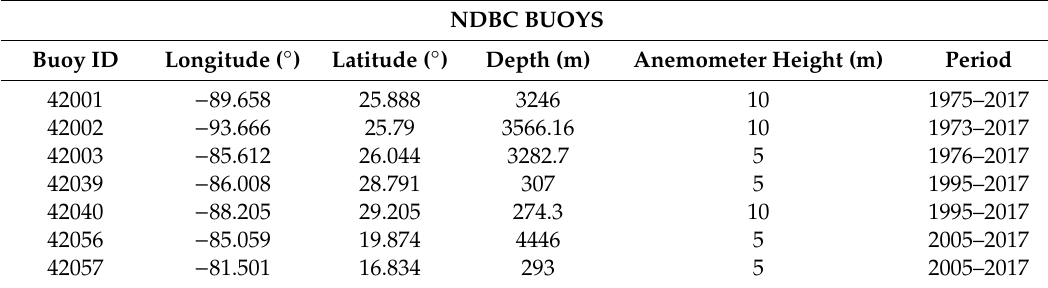
Table 1. Characteristics of the National Data Buoy Center buoys (NDBC) buoys used in this study at the time of